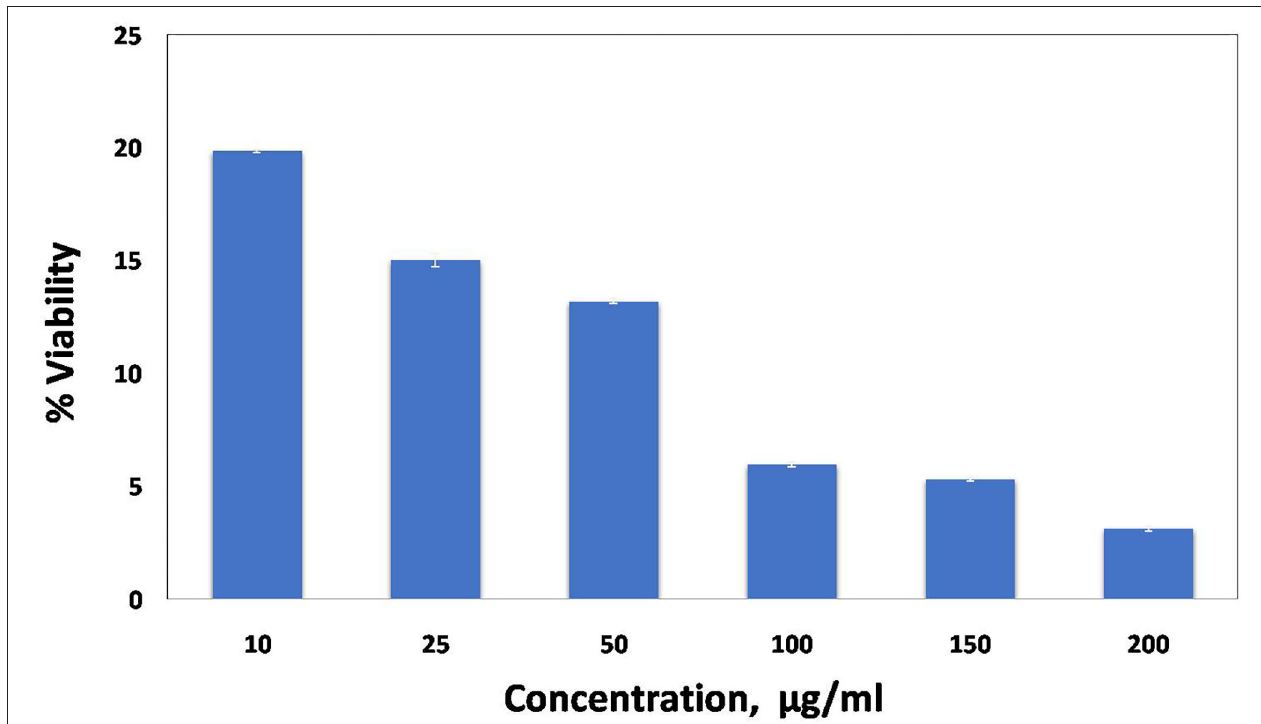
FIGURE 4 | Cell viability by MTT assay. A549 cells treated with embelin